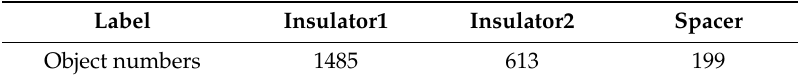
Table 1. Number of objects in each category.